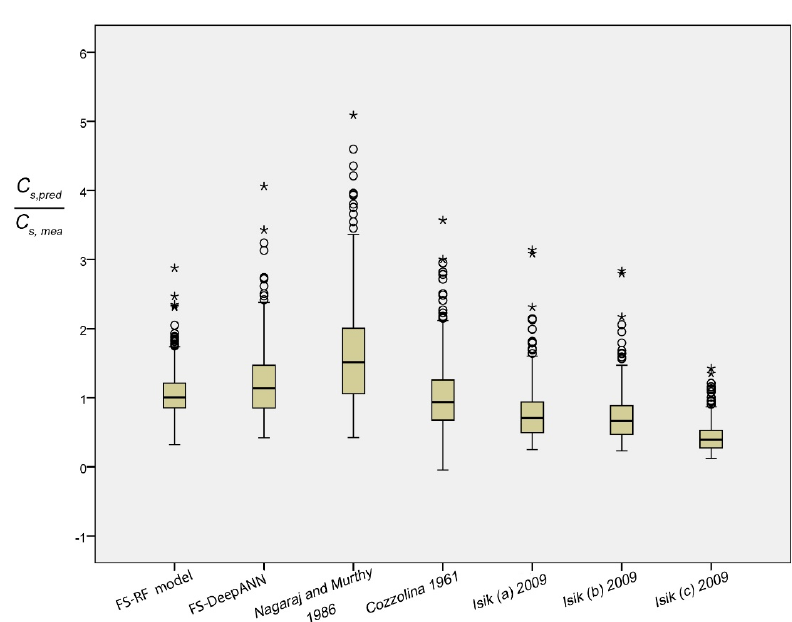
Figure 7. Box plot of the ratio C s , estimated / C s , measured for some empirical formulas and the most appropriate model (Hollow and asterisks circles indicate respectively the extreme and extra-extreme value).